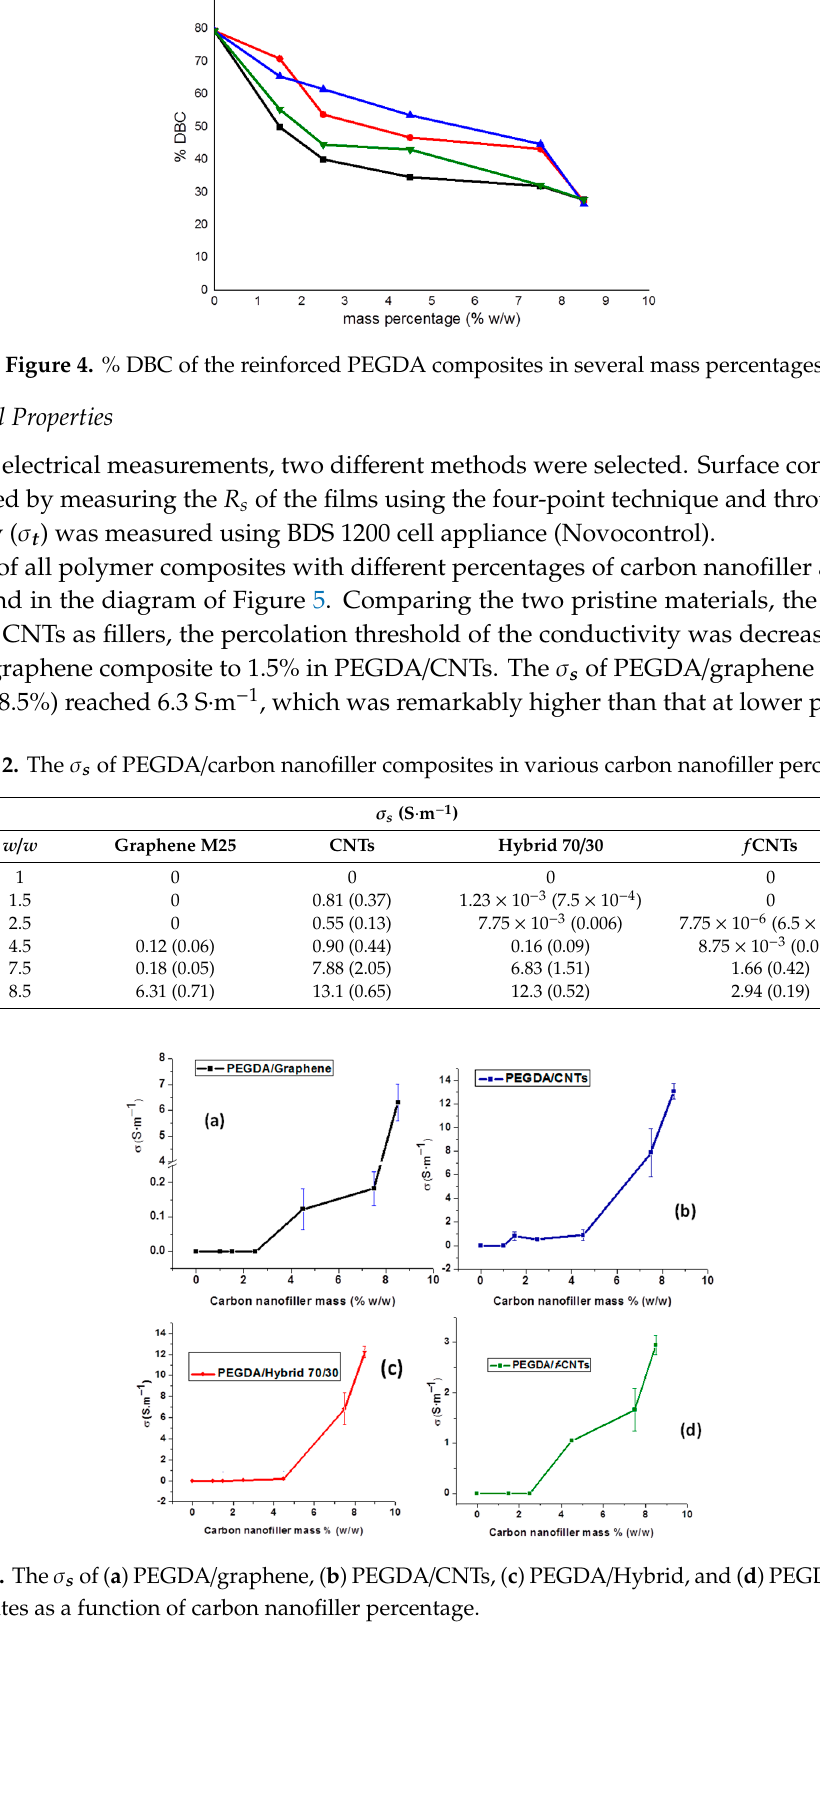
Figure 3. ( a ) Fourier transform infrared (FT-IR) spectra of neat PEGDA before and after ultraviolet (UV) curing. ( b ) The % DBC (double bond conversion) of neat PEGDA as a function of the film thickness.